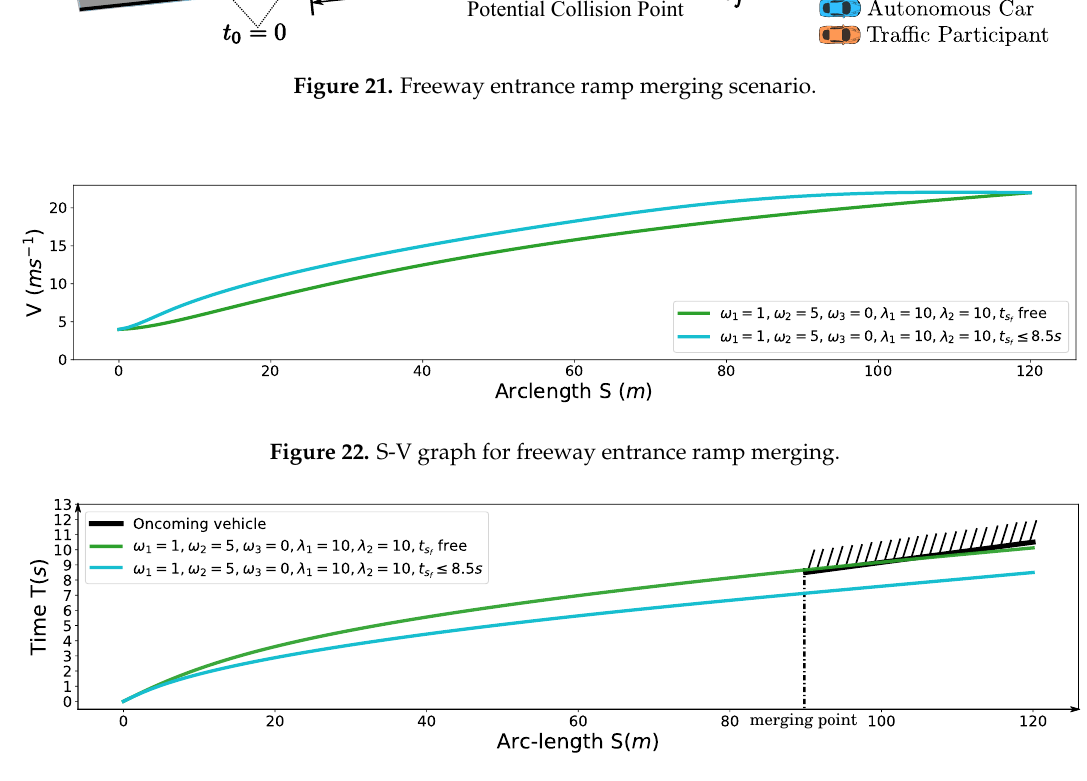
Figure 23. S-T graph for the freeway entrance ramp merging